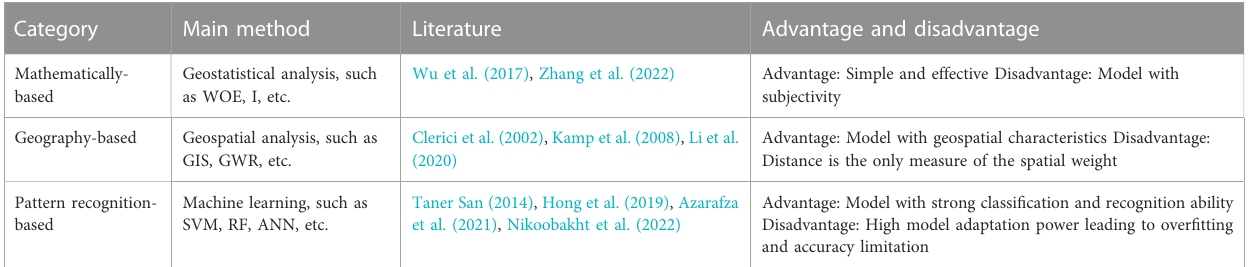
TABLE 1 Statistical methods used for